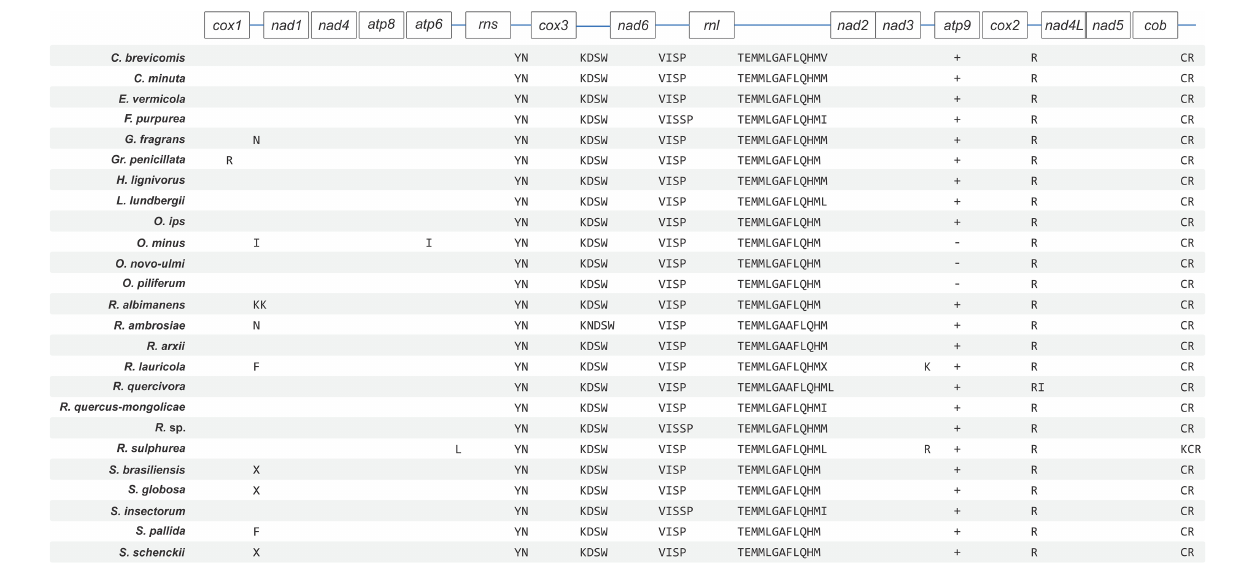
FIGURE 2 | Schematic representation of gene order and position of tRNA gene clusters for members of the Ophiostomatales. Gene order is conserved across the 25 sampled Ophiostomatales with minor variations in tRNA composition and the presence or absence of the atp9 gene. Genes encoding for tRNAs is represented using their respective single-letter amino acid codes. Intron-encoded tRNAs are represented by placing them under the gene that encodes them. Plus (+) and minus (–) signs represent presence and absence of a gene, respectively, and only applies to the atp9 gene. See Supplementary Table 1 for GenBank NCBI accession